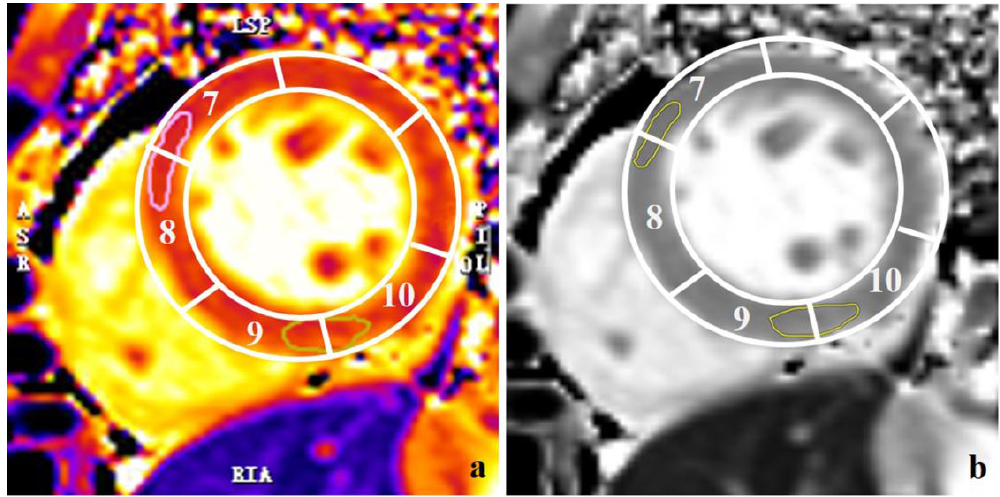
Figure 1. Examples of the measurement of the native T1 values and segmentation of the regions of interest (ROIs) at ARVIP and IRVIP. ( a ). Native T1 values at anterior right ventricle insertion point (ARVIP) and inferior right ventricle insertion point (IRVIP) were measured by delineated regions of interest (ROIs) from the mid-cavity short axis slice between myocardial segments 7/8 and 9/10. The pink circle represents the ROI in ARVIP. The yellow circle represents the ROI in IRVIP. ( b ). Radiomics features were extracted from the segmented ROIs (yellow circles) at ARVIP and IRVIP by using the dedicated platform.